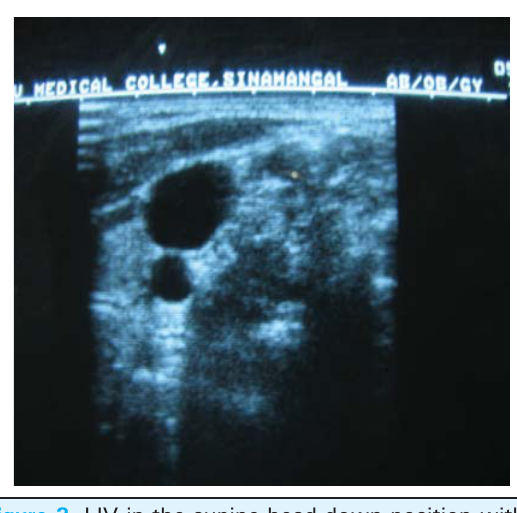
Figure 2. IJV in the supine head-down position with a distended larger-diameter IJV The position of the IJV with respect to the carotid artery at the level of the cricoid cartilage were found to be lateral (35/60), anterolateal (22/60) and anterior (5/60) in the ultrasound group. Such an inter-individual anatomical variation accounts for unsuccessful cannulation of the IJV during the blind techniques. Ultrasound has been found to be a valuable tool